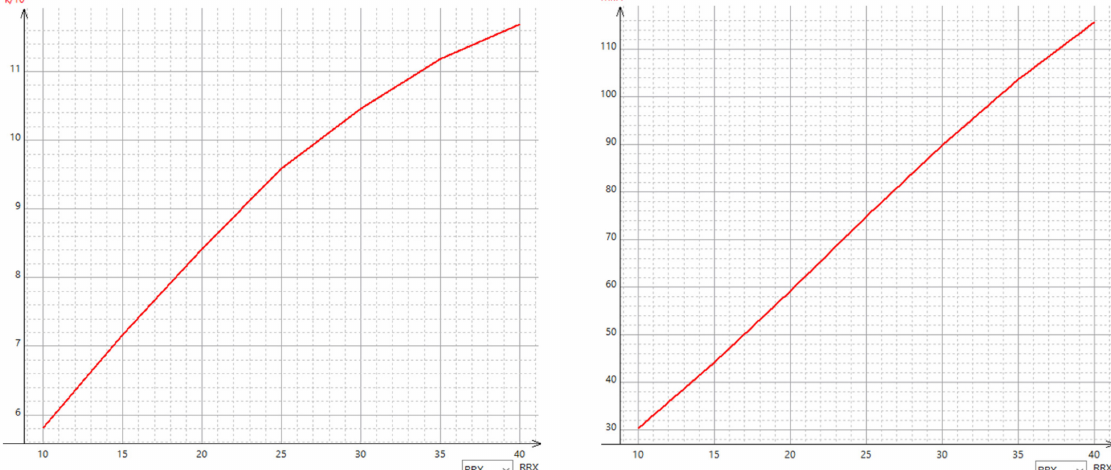
Figure 12. R RX variation simulation results of circular coil model: k in the function of R RX and M in the function of R RX